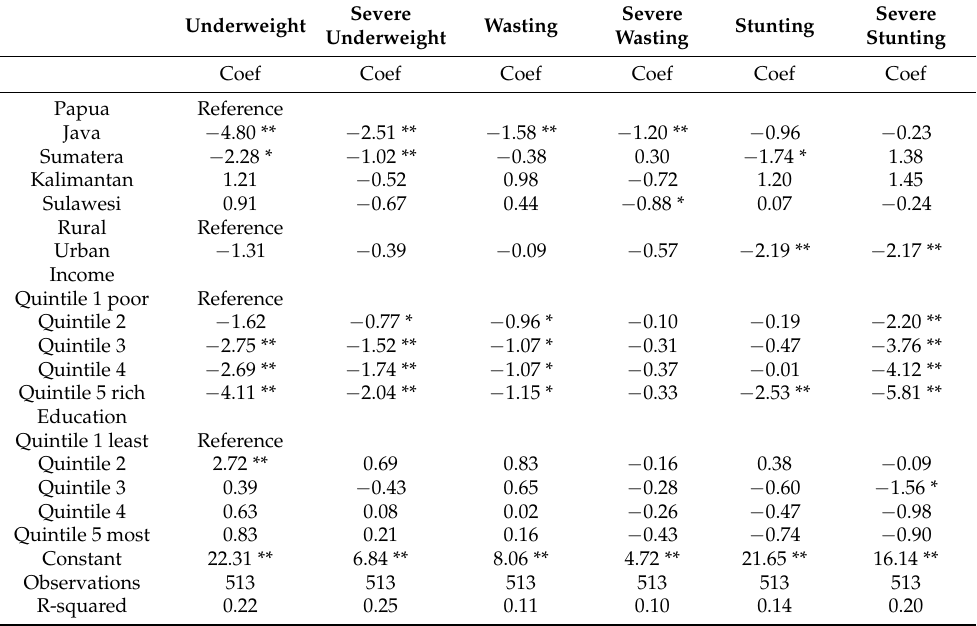
Table A3. Regression outputs for geographic and socioeconomic disparity in child